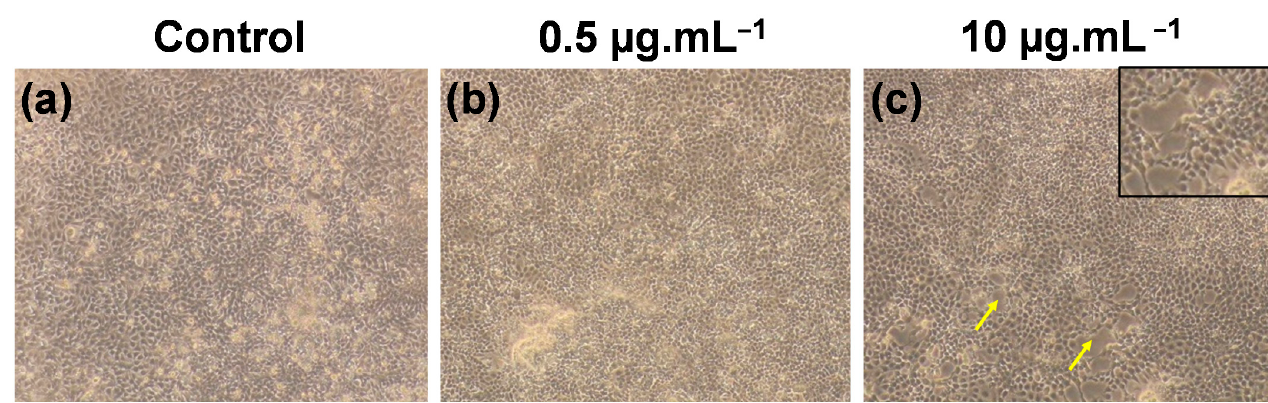
Figure 5. Microscopy images of ( a ) control (without GO exposure) and ( b , c ) GO-treated NPC-BM1 cells at 72 h. The GO concentrations are shown above ( b , c ). Images were taken at 100× magnification. The arrows indicate the GO interaction with cell and its cell damage.